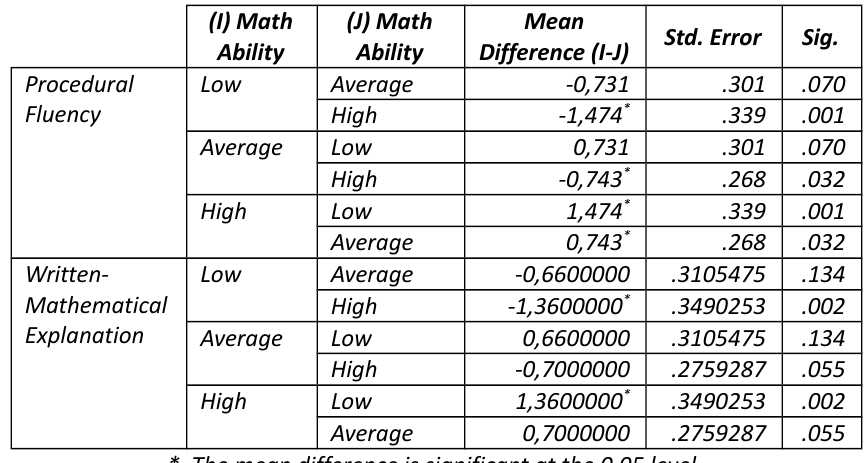
Table 4. Bonferroni Correction Post Hoc Test on the Performance of the Students on Select Constructed Response Task in